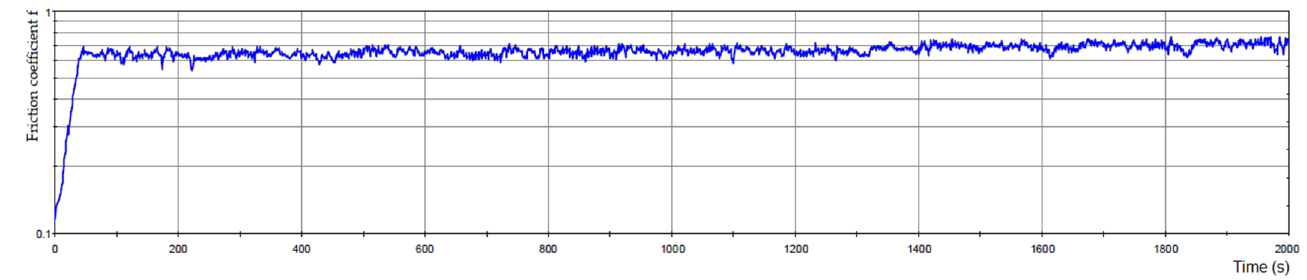
Figure 16. The friction coefficient of alloys depending on time.